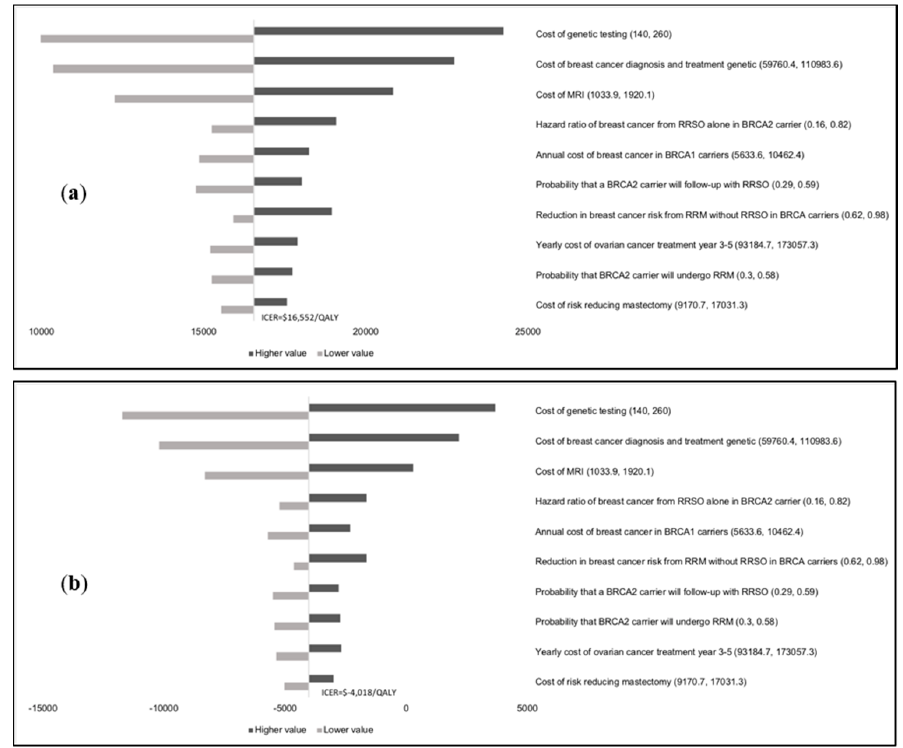
Figure A2. Tornado Diagram in the USA ( a ) from the healthcare payer perspective. ( b ) from the societal perspective.